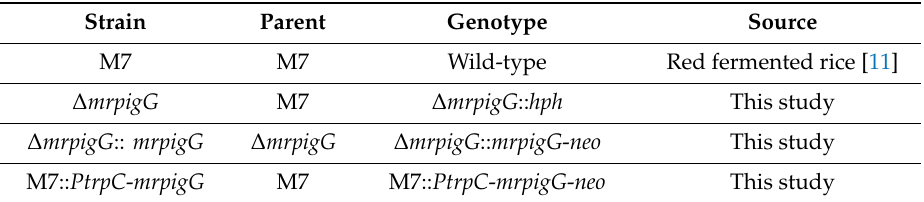
Table 1. Monascus ruber strains constructed and used in this